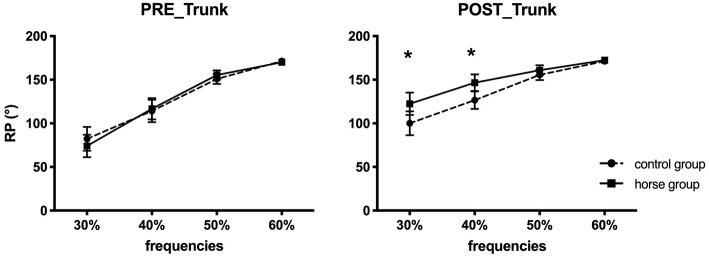
Depiction of trunk/horse relative phase (mean ± standard-error) in the pre- and post-tests, for the control (dashed line) and horse (continuous line) groups. *Characterizes significant differences between groups.